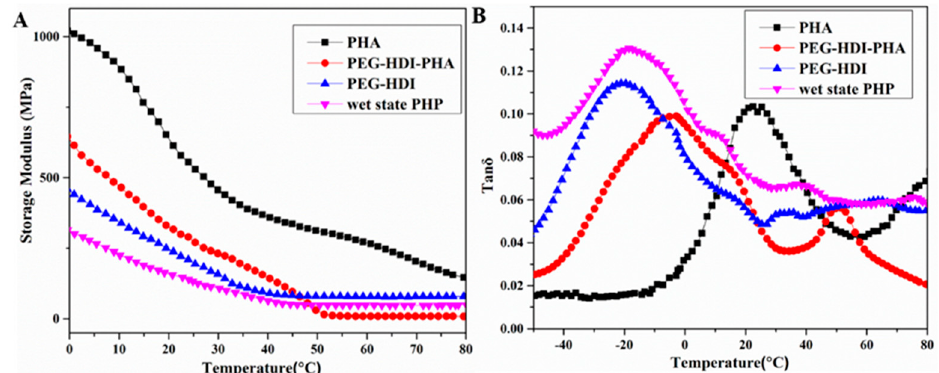
Figure 7. Dynamical mechanical analysis of PHA, PEG–HDI, and PEG–HDI–PHA for ( A ) storage modulus and ( B ) tan δ .